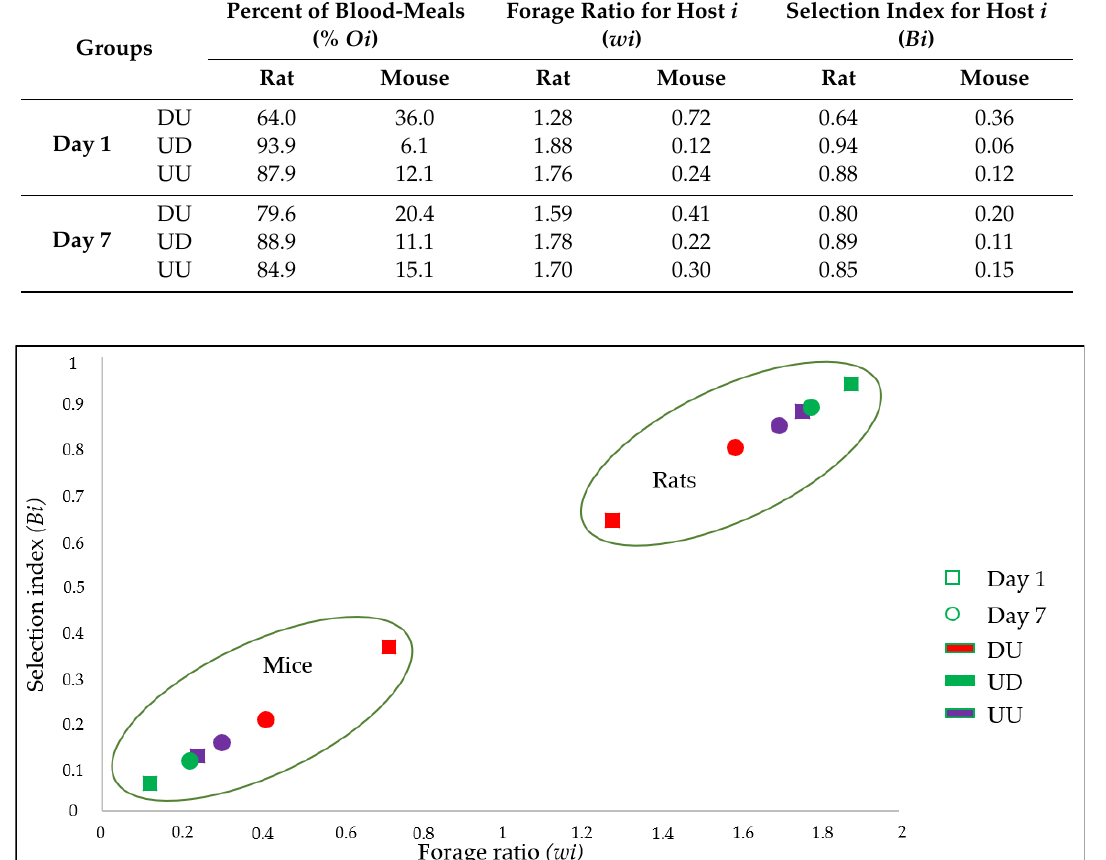
Figure 2. Scatter chart showing feeding preferences of Ae. albopictus mosquitoes in term of hosts and treatments according to the forage ratio ( wi ) and selection index ( Bi ). DU: DPP-treated rats vs. untreated mice, UD: DPP-treated mice vs. untreated rats, UU: Control group. Day 1 and 7: Time of post-treatment exposure.